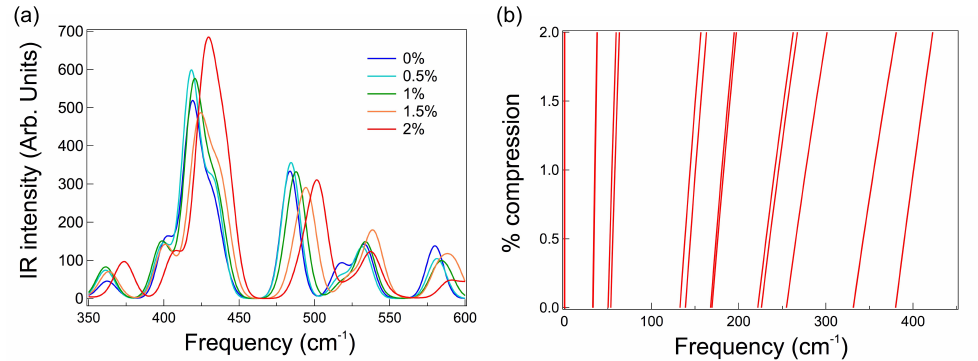
Figure 3. ( a ) Calculated infrared spectra of the building block anion [Ho(W 5 O 18 ) 2 ] 9 − at different compressive strain values (from 0 to 2%) in the 350–600 cm − 1 region. ( b ) Evolution of the spin energy levels of Ho(W 5 O 18 ) 2 ] 9 − under compressive strain calculated by the radial effective charge model. Na 9 [Ho(W 5 O 18 ) 2 ] · 35H 2 O already benefits from a relatively sparse lattice (due to